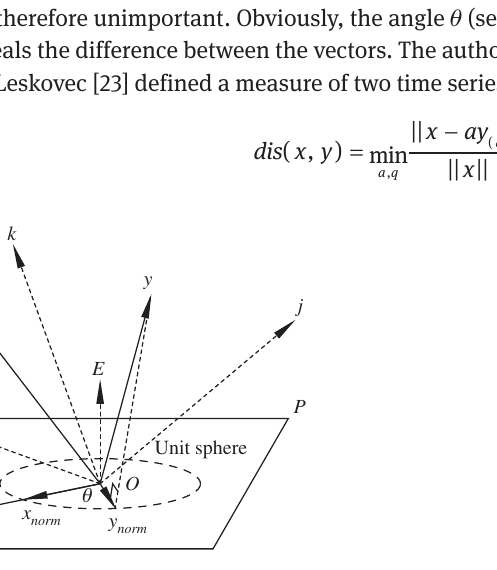
Figure 1. Projecting Time Series to Eliminating